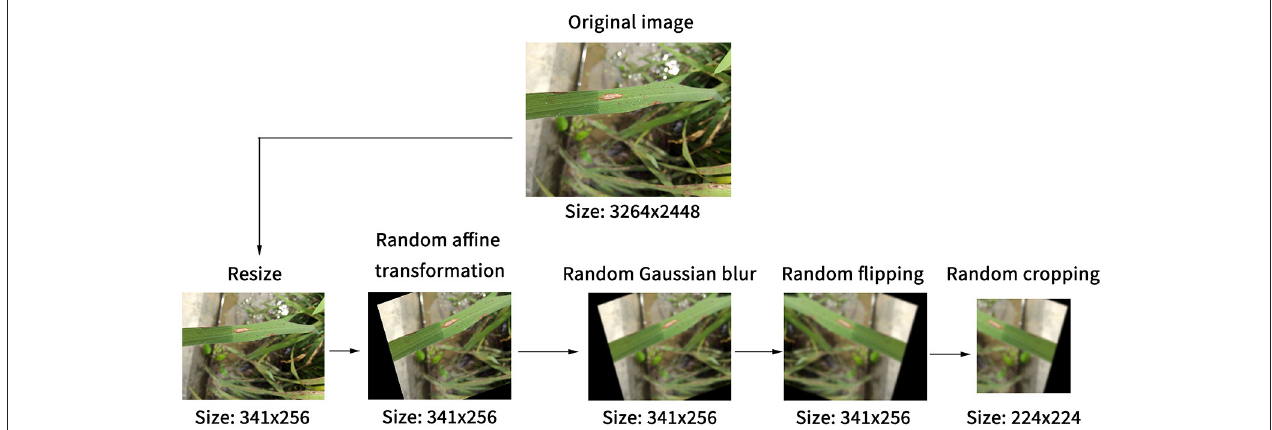
FIGURE 1 | Steps of the image preprocessing for expanding dataset and reducing the overfitting of